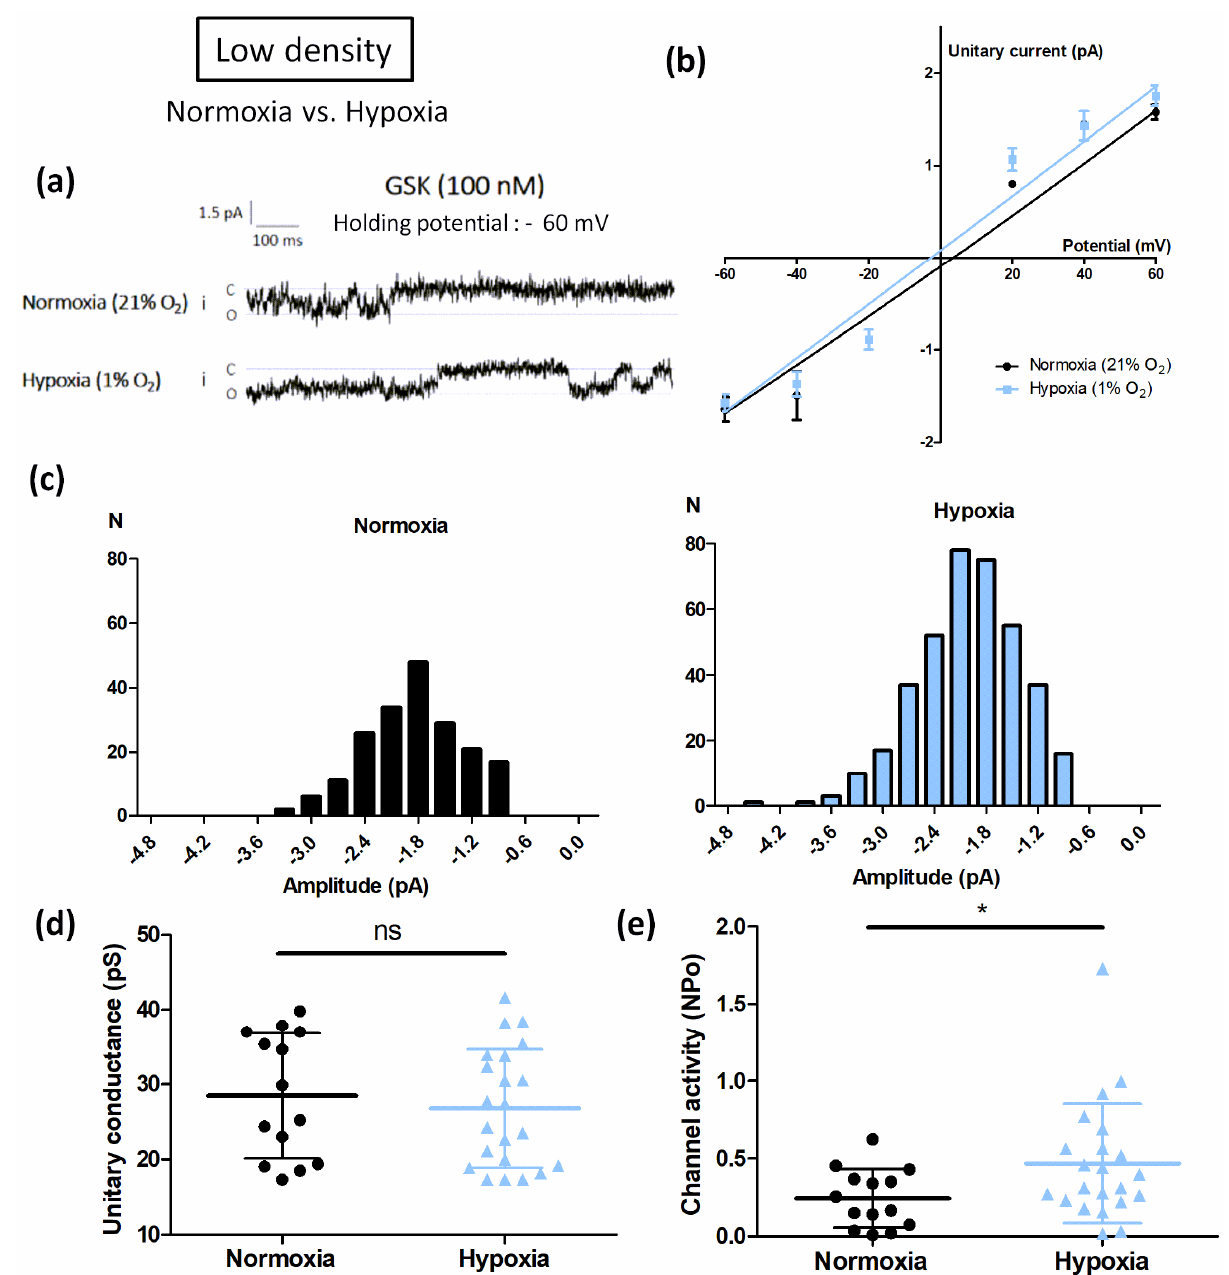
Figure 4. Hypoxia potentiates TRPV4 currents in transiently TRPV4-transfected HEK293T (HEK- TRPV4) cells cultured at low density (1 × 10 4 cells/cm 2 ). ( a ) Representative records of current traces (patch clamp; cell-attached configuration at − 60 mV holding potential, assuming a resting potential of 0 mV) recorded in HEK-TRPV4 cells cultured under normoxia (21% O 2 ) or hypoxia (1% O 2 ) for 48h at low cell confluence (1 × 10 4 cells/cm 2 ). The letters c and o indicate the closed and open channel states, respectively. ( b ) Unitary current (i)/potential (V) curves, ( c ) corresponding amplitude histograms shown at − 60 mV, ( d ) unitary conductance, and ( e ) channel activity (NPo), determined at a holding potential of − 60 mV in presence of the TRPV4 agonist GSK1016790A (100 nM). Data are expressed as mean value ± SD. Significant difference is indicated by one asterisk when p < 0.05, and ns indicates a non-significant difference, Mann–Whitney